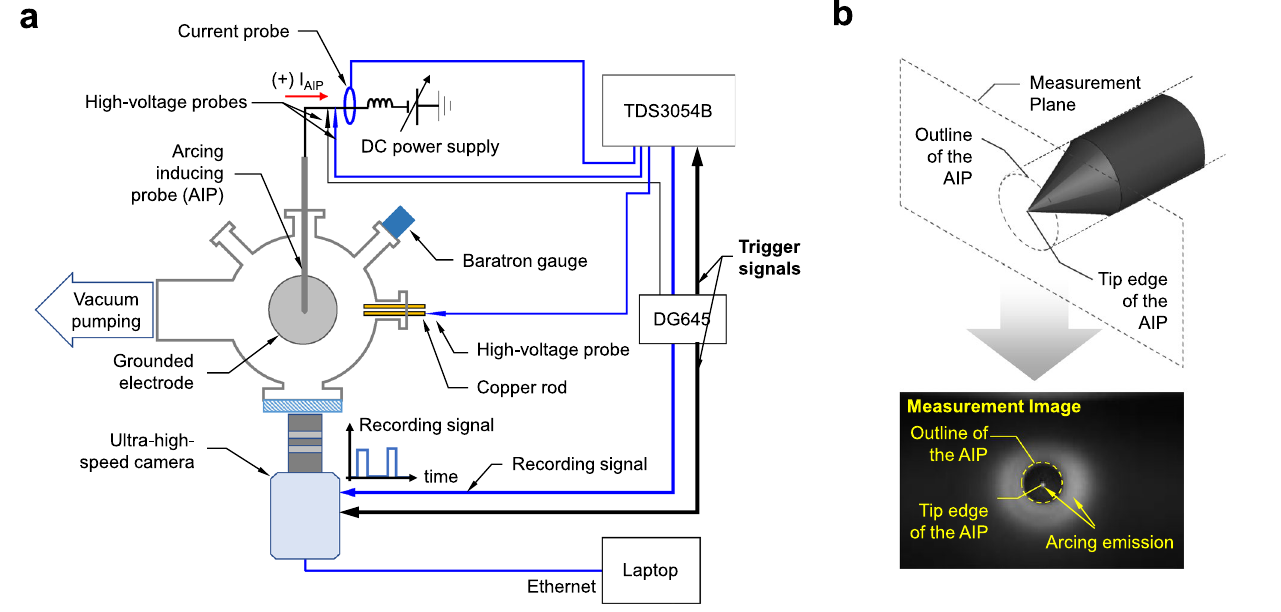
Figure 3. ( a ) Planar schematic of the experimental setup. ( b ) Measurement plane of the ultra-high-speed camera and example measurement